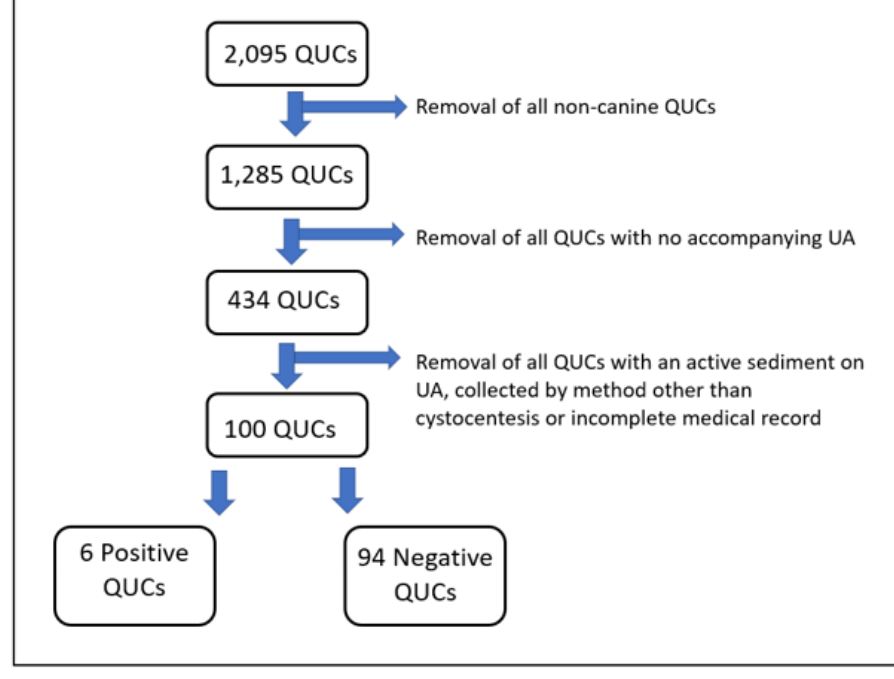
Figure 1: Flow chart depicting the exclusion process of the quantitative urine cultures (QUCs) in this study. UA =